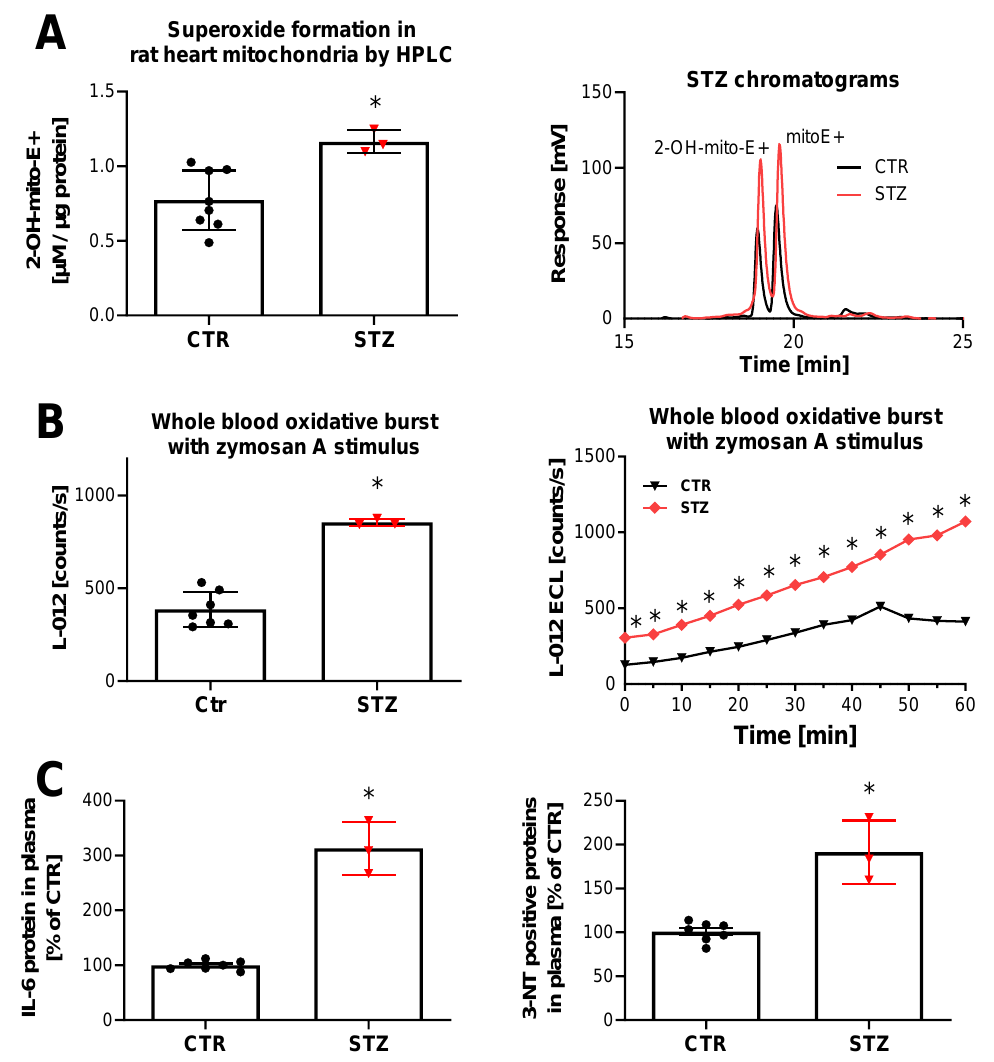
Figure 5. Detection of mitochondria and NOX-derived ROS formation as well as inflammation